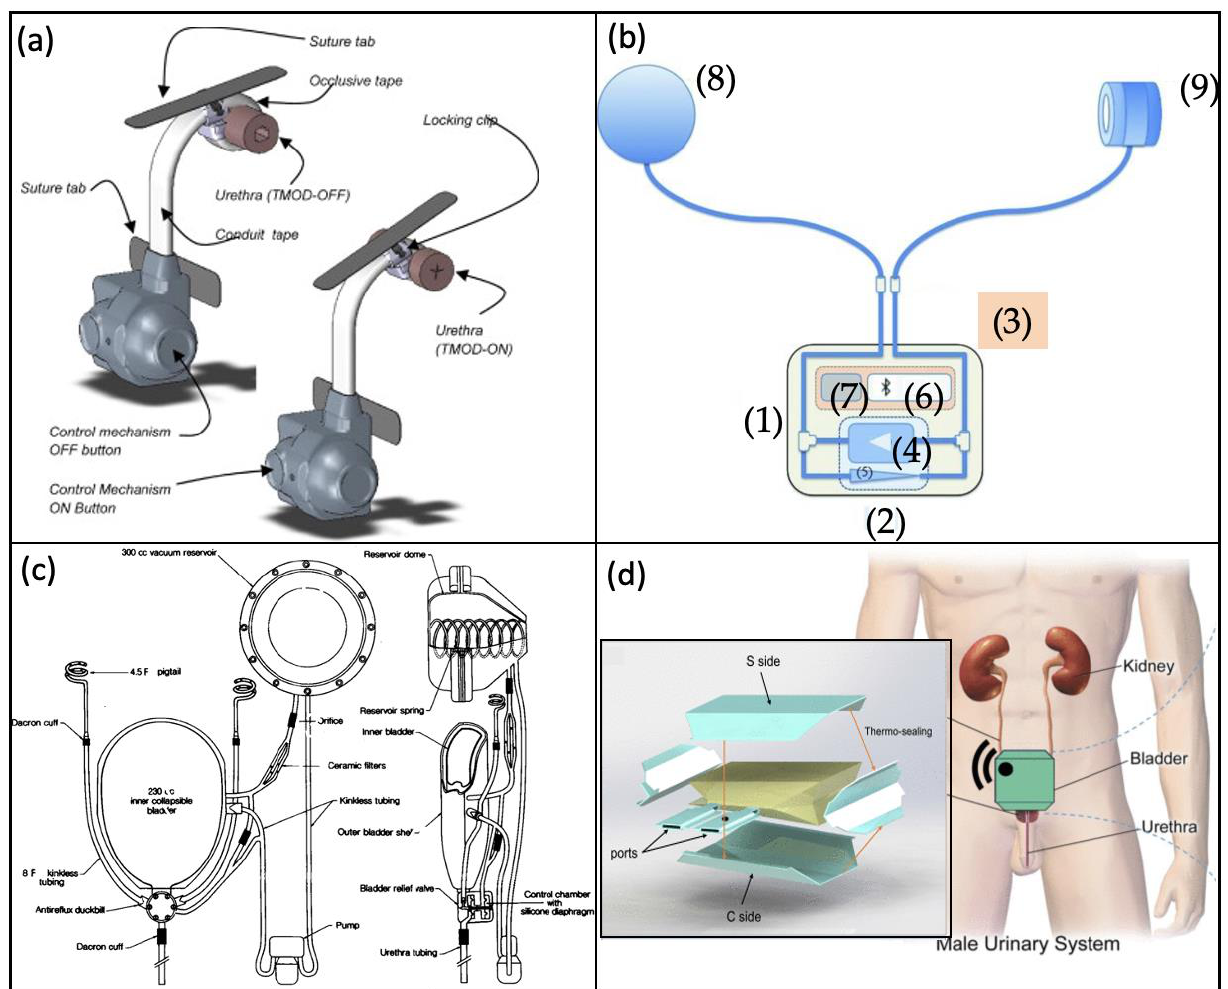
Figure 14. Prosthetic devices. ( a ) Tape mechanical occlusive device (TMOD) [67]. Copyright